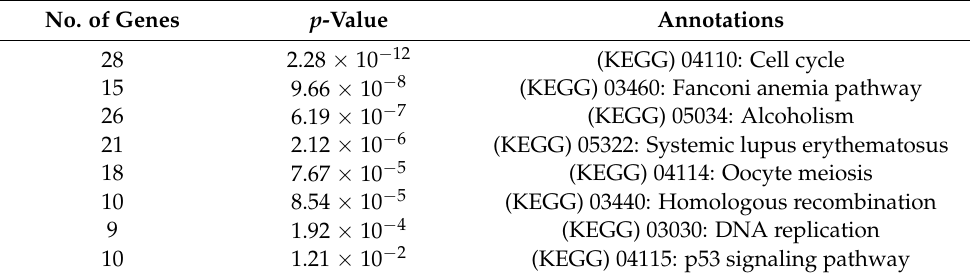
Table 3. Significantly enriched annotations of the upregulated genes identified by microarray expression analysis of SCLC clinical